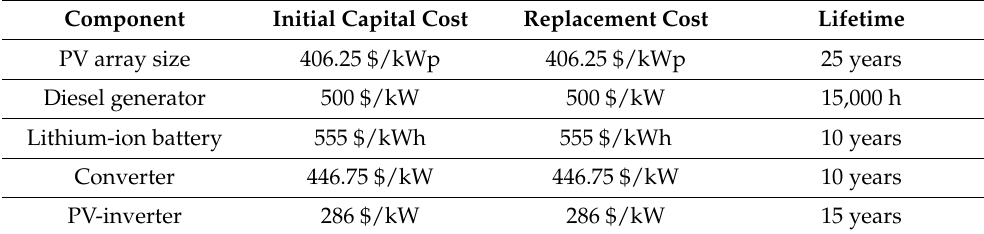
Table 1. Mini-grid component cost data